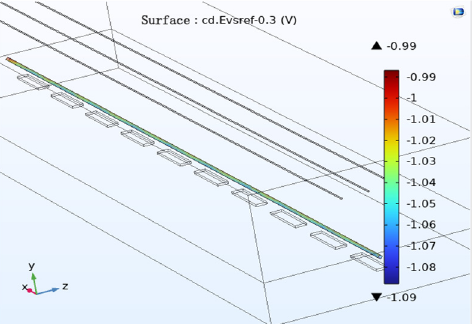
Figure 6. Distribution of cathodic protection potential of the pipeline.